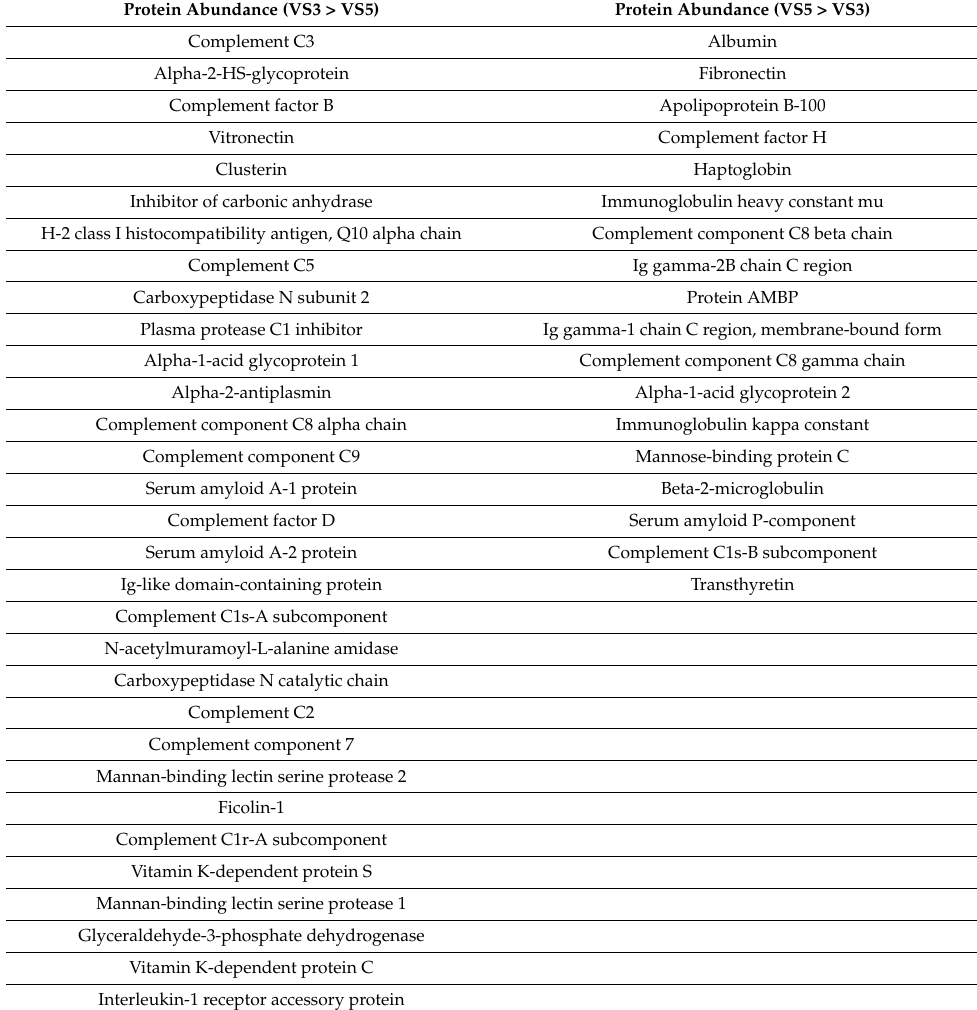
Table 2. Comparison of proteins absorbed by HBPE-NPs from VS3 or VS5 that could promote inter- actions with monocytes/macrophages, based on known functional data (https://www.uniprot.org/). Abundance was determined by multiplying the individual protein spectral count by (the average total spectral count among samples divided by the total spectral count for an individual sample). Protein Abundance (VS3 > VS5) Protein Abundance (VS5 > VS3) Complement